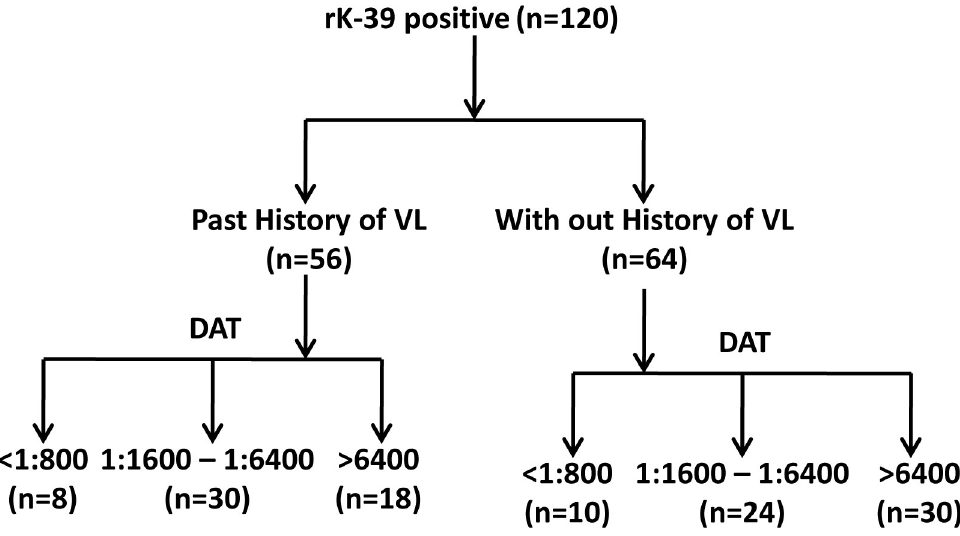
Fig 1. Flow diagram of serological